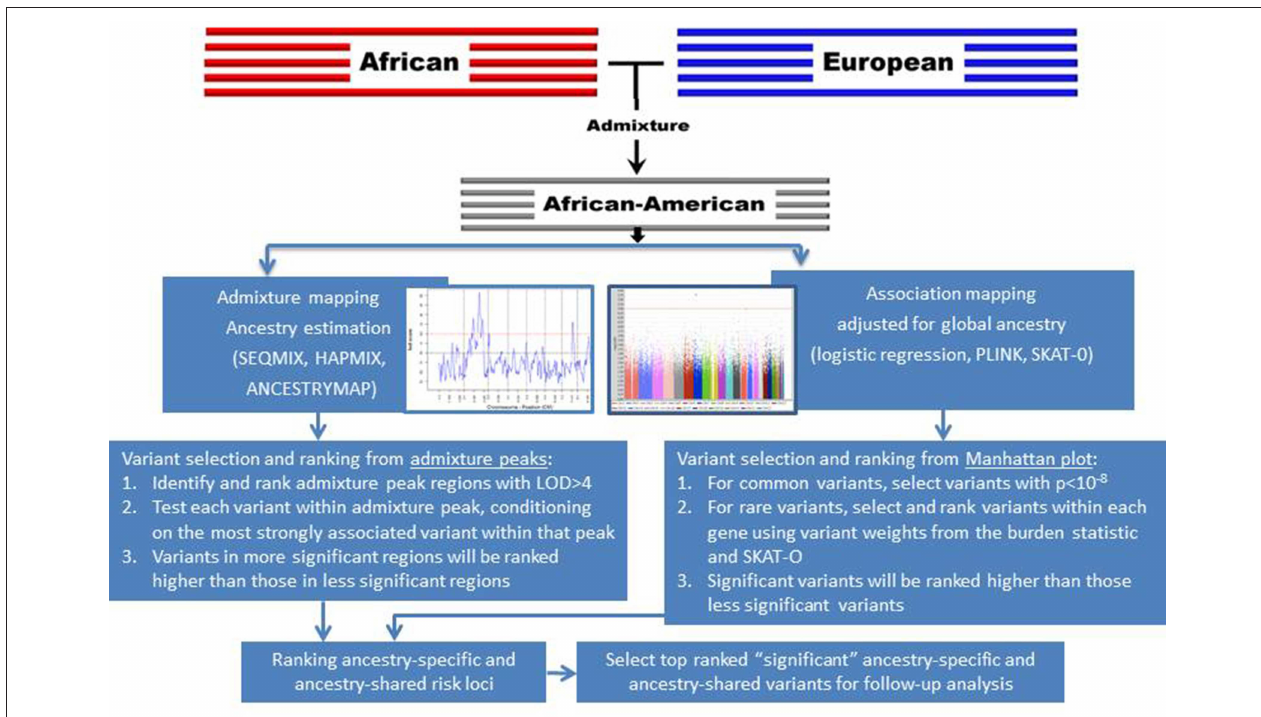
FIGURE 5 | Strategies to prioritize ancestry-specific risk loci via admixture mapping and ancestry-shared risk loci via GWAS for follow-up genotyping and analysis.